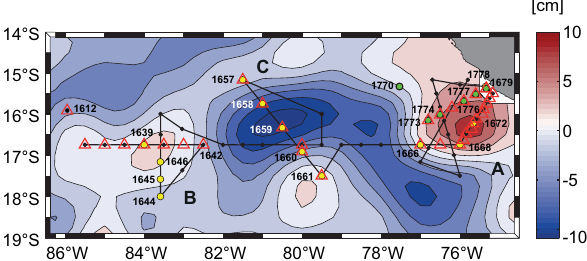
86°W Figure 1. Map of sampling locations in the ETSP. Aviso sea level height anomaly for 21 November 2012 is shown (anticyclonic ed- dies are depicted in red, and cyclonic in blue). The cruise track and CTD stations with bottle sampling from the M90 cruise are shown in black. Open triangles indicate the hydrographic stations shown in Fig. 2. Sampling stations within the mode water eddies A and B as well as the open-ocean cyclonic eddy C are highlighted in yellow, whereas the cross-shelf section carried out during the M91 cruise is displayed in green. Station 1770 from the M91 cruise was used for the molecular work shown in Fig.